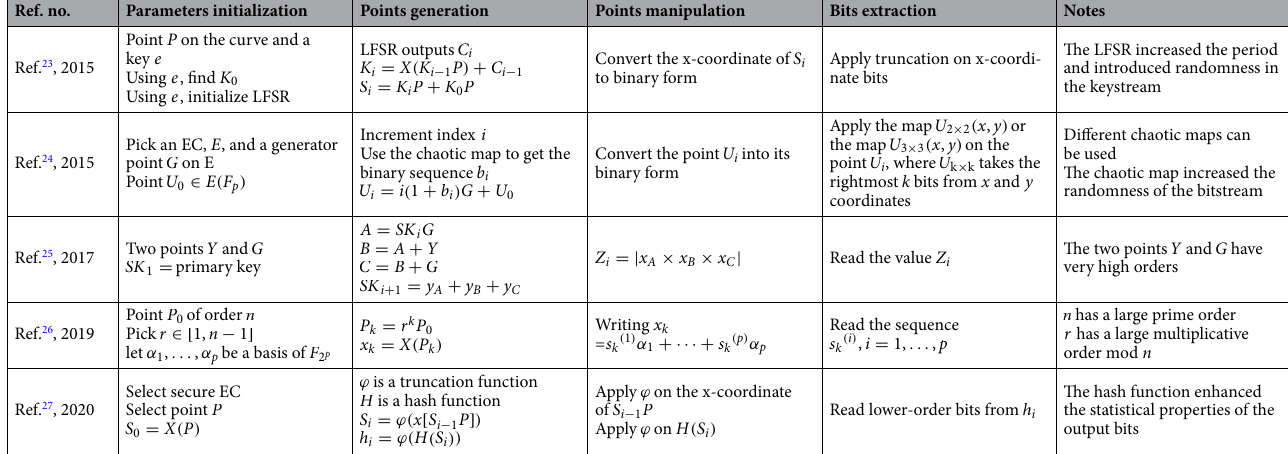
Table 2. Mapping of the surveyed iterative techniques into the proposed framework.